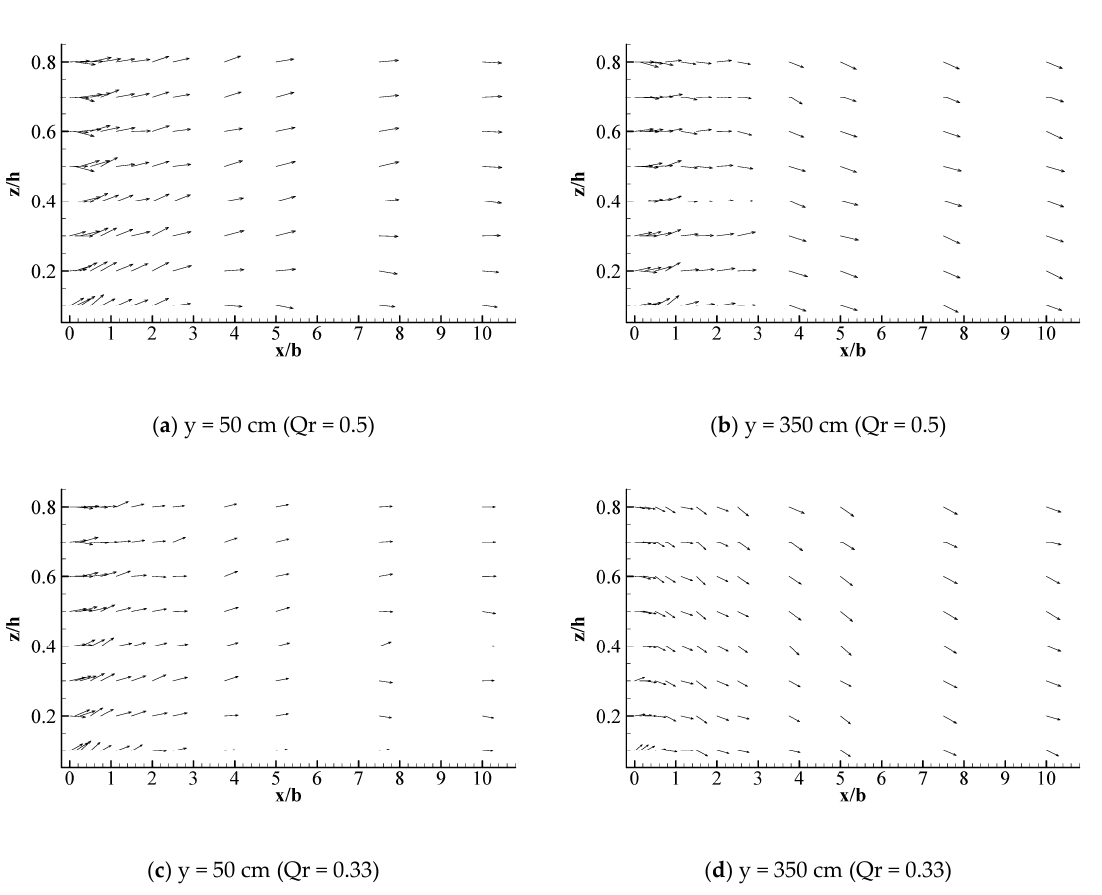
Figure. 8. Horizontal flow velocity vector for the intersecting water flow. Figure 8. Horizontal flow velocity vector for the intersecting water